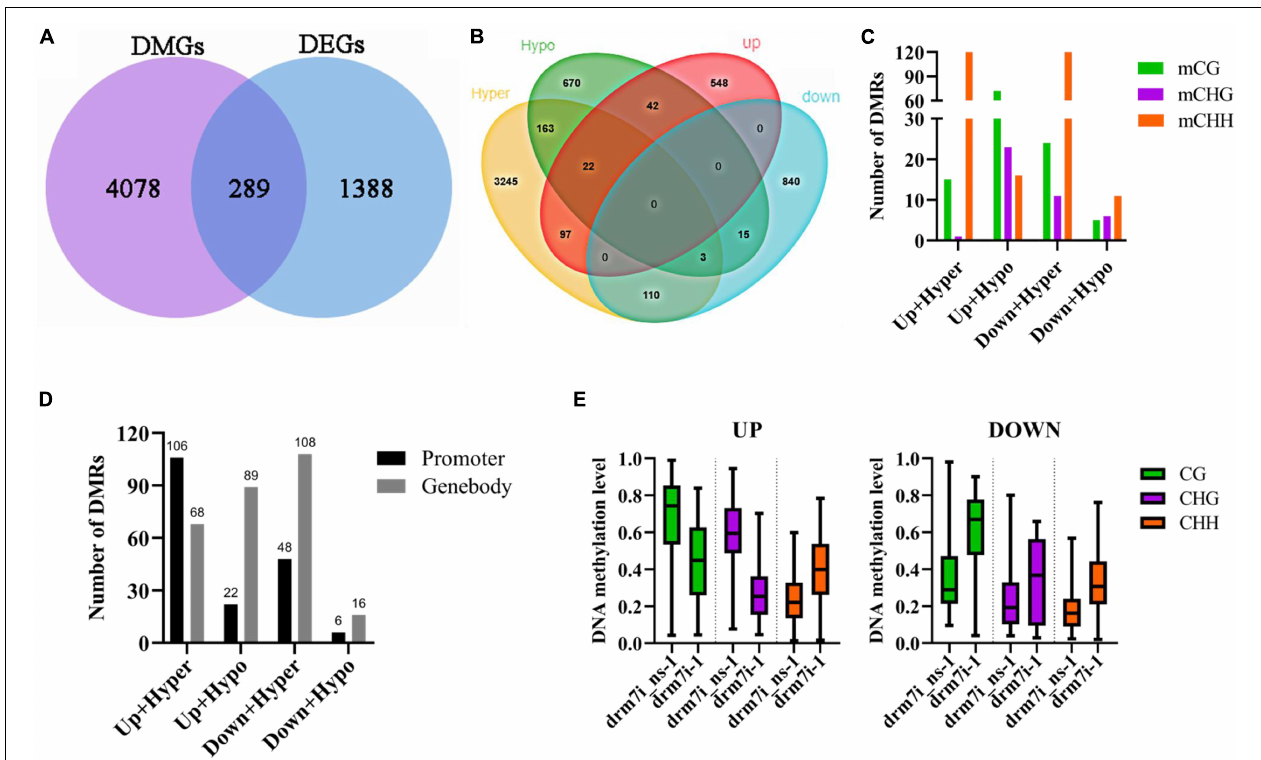
FIGURE 5 | Combinational analysis of differential DNA methylated genes (DMGs) and differentially expressed genes (DEGs). (A) Venn diagrams of DMGs and DEGs (fold change > 2, FDR < 0.05, and drm7i-1 or drm7i_ns-1 FPKM > 1). (B) Venn diagrams of hypermethylated/hypomethylated genes and up-/downregulated genes. (C) Numbers of meth-DMGs in CG, CHG, and CHH contexts. (D) Numbers of meth-DMGs with DMRs located at promoters or gene bodies. (E) Overall DNA methylation levels of meth-DEGs in drm7i-1 vs.